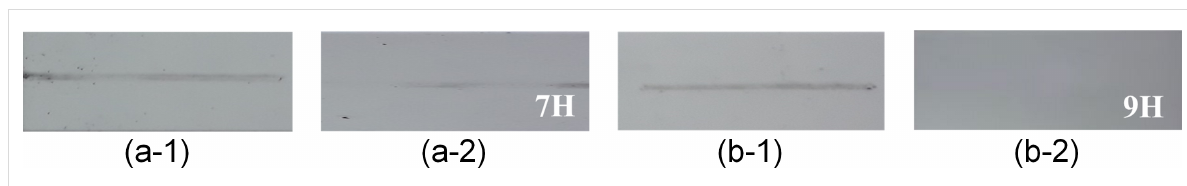
Figure 6: Hardness characteristics of the coating films fabricated using various annealing treatment methods: (a-1) naturally dried; (a-2) coating film after the hardness test; (b-1) annealed; and (b-2) coating film after the hardness test.